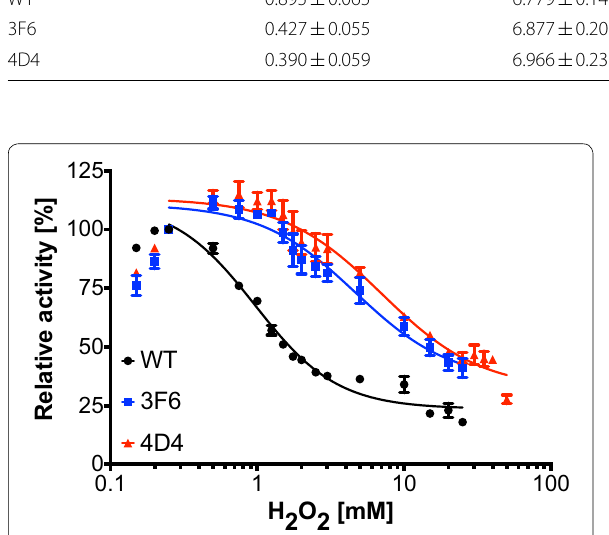
Fig. 5 Relative ABTS oxidation activities of purified WT (black), 3F6 (blue) and 4D4 (red), at increasing H 2 O 2 concentrations from 0.15 to 50.00 mM, with ABTS concentration kept at 7 mM. The WT activity at 0.25 mM H 2 O 2 was arbitrarily set as 100% and used as a reference point